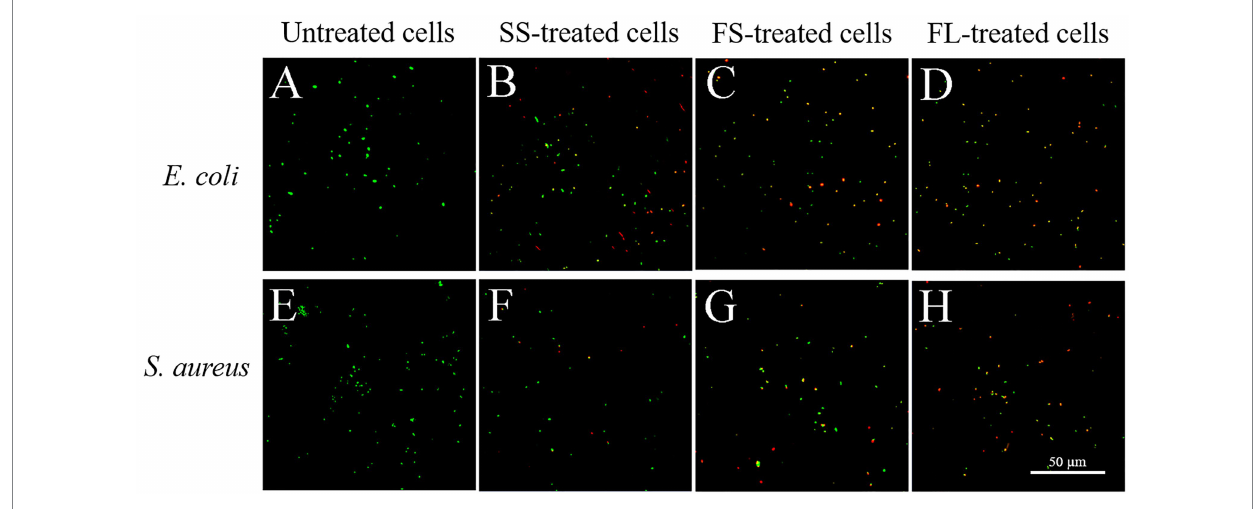
FIGURE 4 Confocal laser scanning microscope images of E. coli and S. aureus treated by high hydrostatic pressure (250 MPa/5 min and 450 MPa/5 min, respectively) and stained with SYTO 9 and PI. (A,E) Control. (B,F) SS treatment. (C,G) FS treatment. (D,H) FL